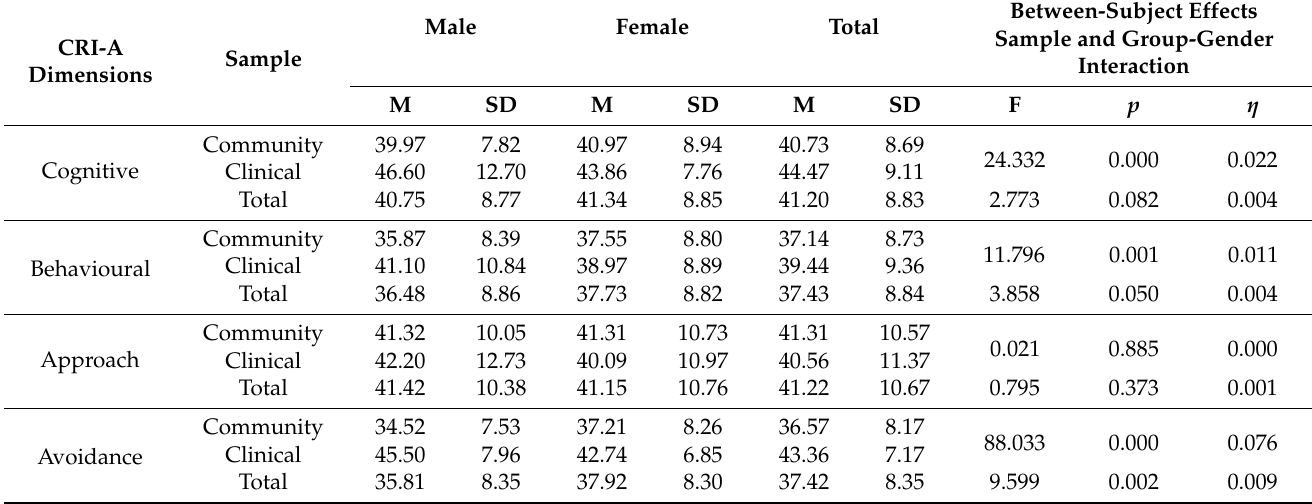
Between-Subject Effects Sample and Group-Gender Interaction η